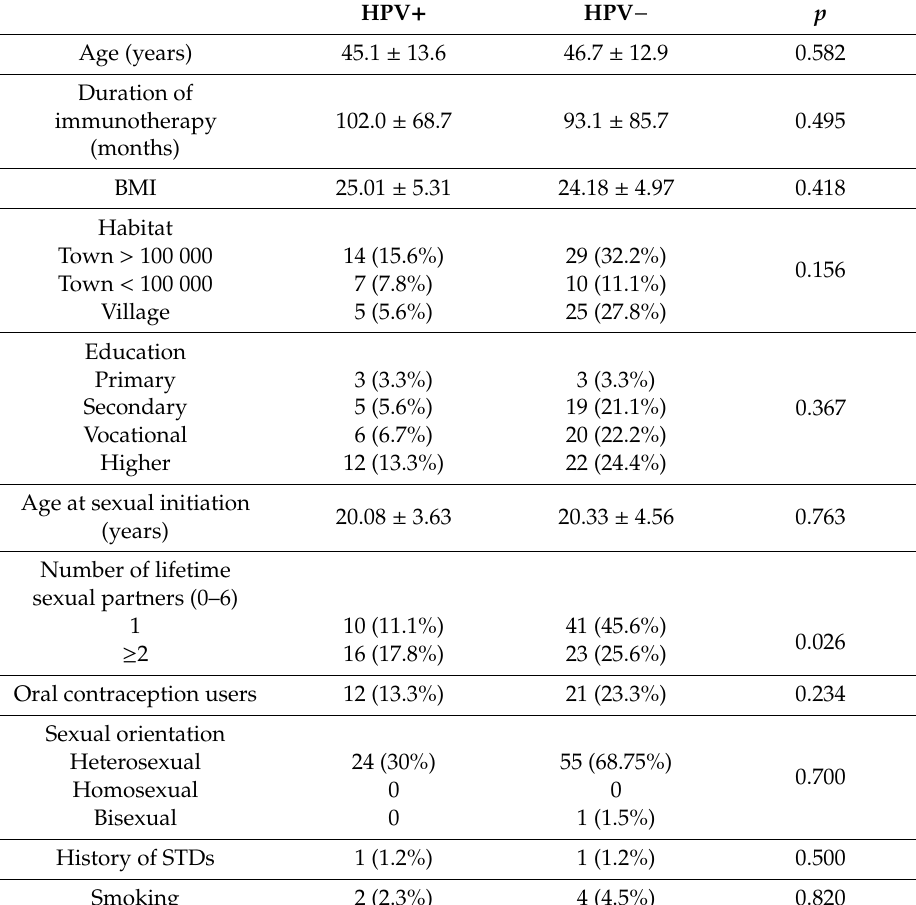
Table 3. Group characteristics and risk factors of HPV infection.